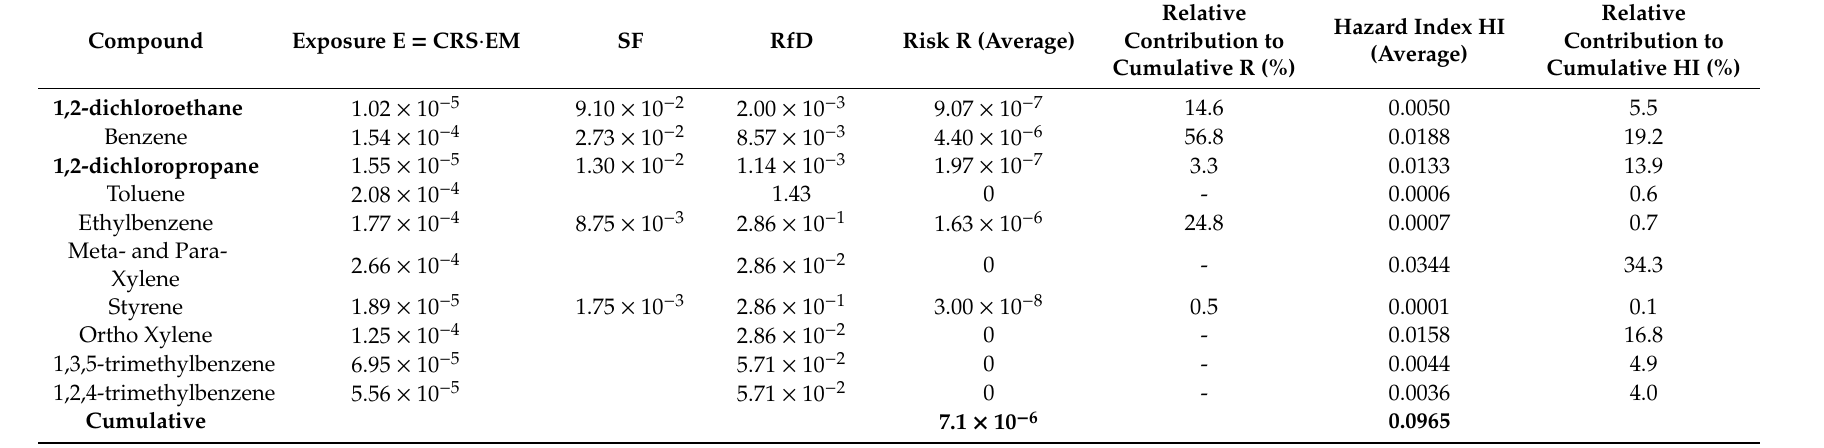
Table 7. Results of the health risk